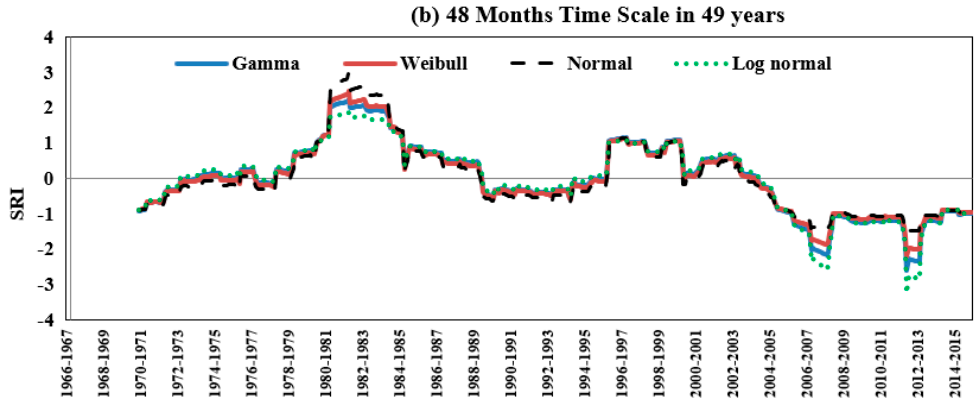
Figure 3. Drought monitoring using different probability distribution functions; ( a ) 30 years and ( b ) 49 years.